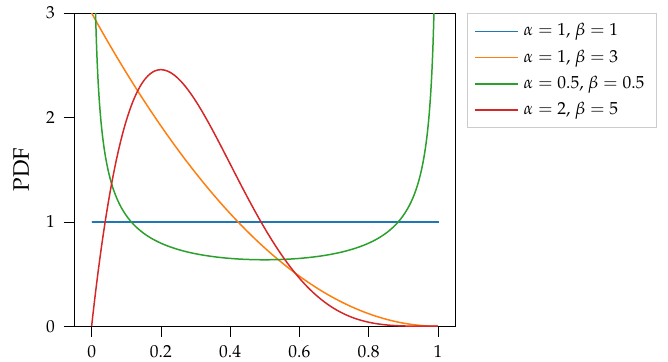
Figure 4. Probability density function (PDF) of the Beta distribution for some examples of shape parameters α and β